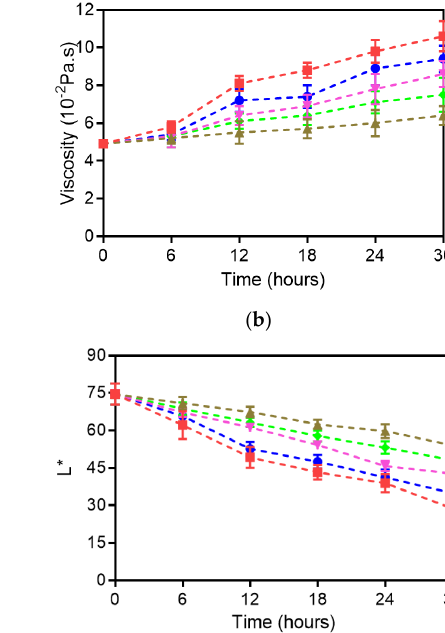
Figure 2. The values for the total polar compounds (TPC, ( a )), thiobarbituric acid (TBA, ( b )), conjugated dienes ( c ) and conjugated trienes ( d ) of sunflower oil added by nothing, LJEO (0.06 g/kg), TBHQ (0.09 g/kg), BHA (0.12 g/kg), and BHT (0.12 g/kg) during the deep-frying of youtiao for 30 h. Values are expressed as means ± SD (n = 10).